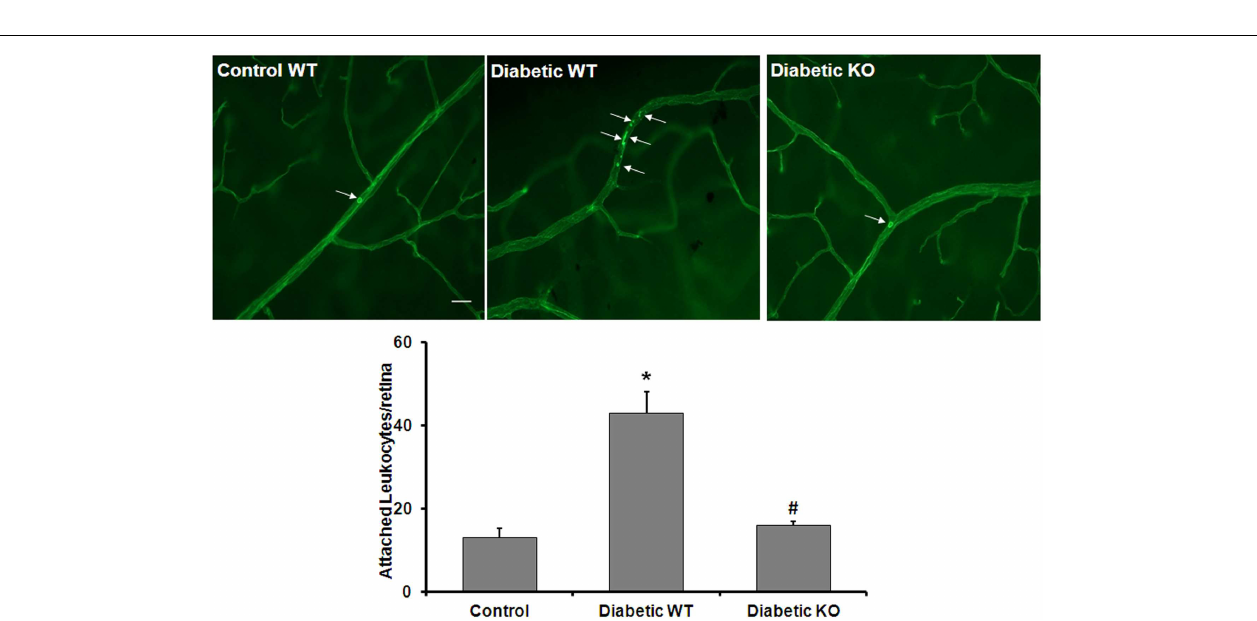
FIGURE 6 | Prevention of high glucose-induced increase in oxidative stress by arginase inhibition. Retinal EC (p5–p9) were incubated in medium (M199 + 0.2%FBS + 50 µ M l-arginine) containing 5.5mM d-glucose (NG) or 25mM d-glucose (HG) for